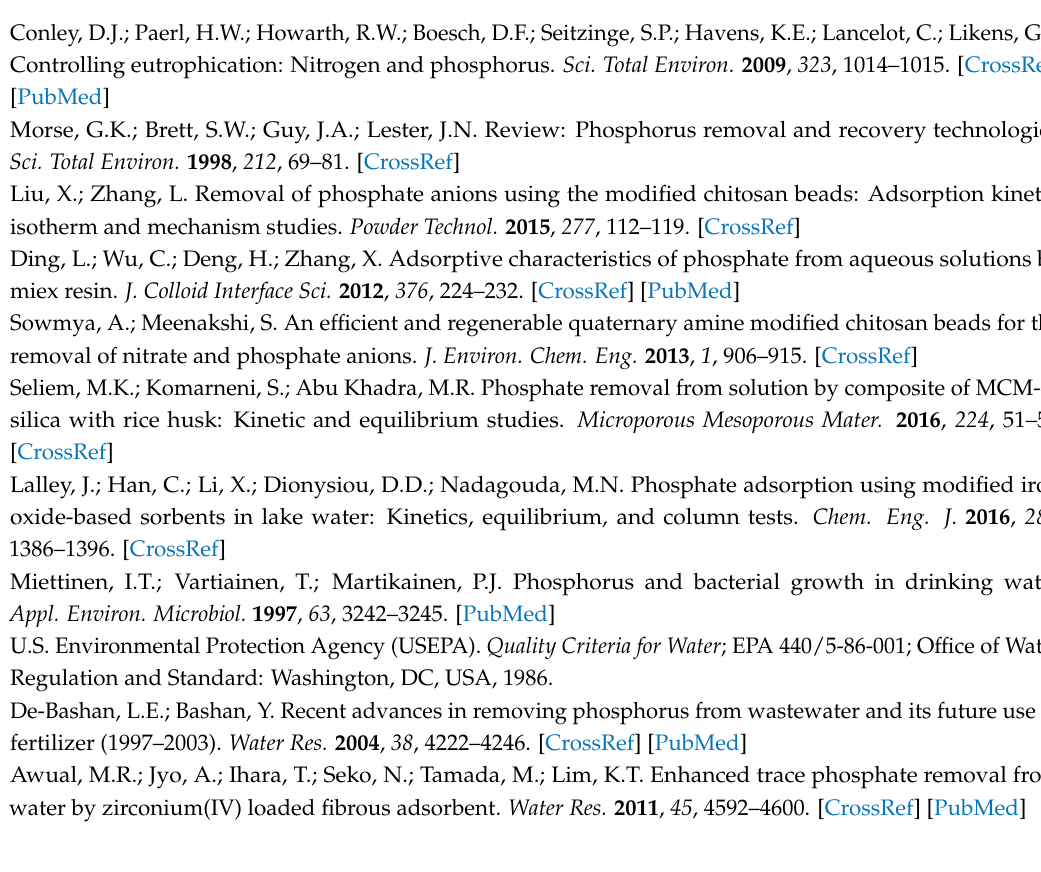
Figure S1: The linear plot of t / q t versus t for the determination of psodo-second-order kinetic model parameters via linear regression. Figure S2: (a) Theoretical q t (lines) by pseudo-first-order kinetic model; and (b) theoretical q t (lines) by pseudo-second-order kinetic model compared to experimental q t (markers). Figure S3: (a) Theoretical values of q e (lines) from Langmuir isotherm model; and (b) theoretical values of q e (lines) from Freundlich isotherm model compared to experimental q e (markers). Figure S4: The plot of ln( q e / C e ) versus C e for determination of K 0